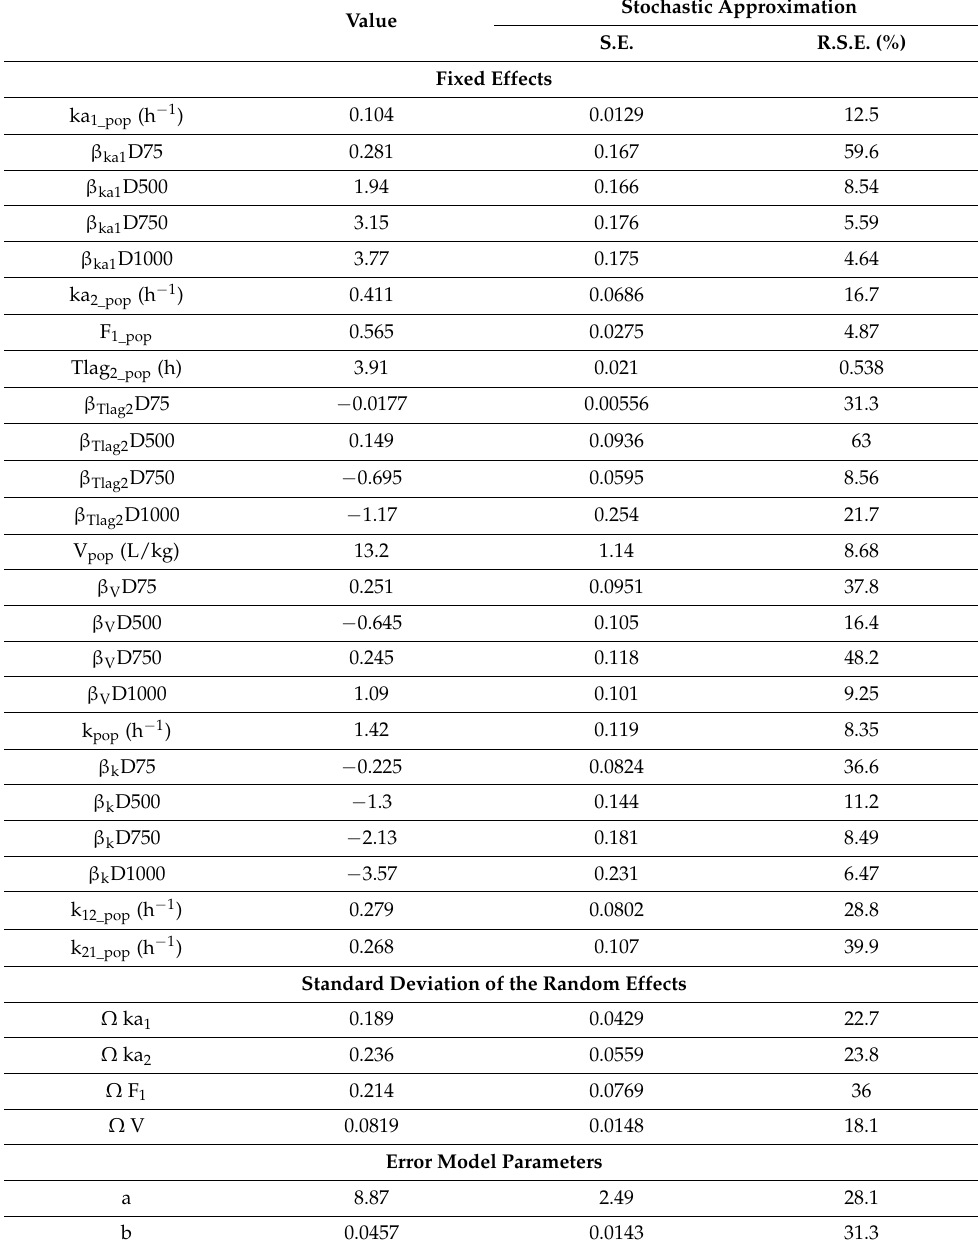
Table 5. Population pharmacokinetic parameters of quercetin after oral administration of pure rutin and of the extract of calyces of Physalis peruviana .